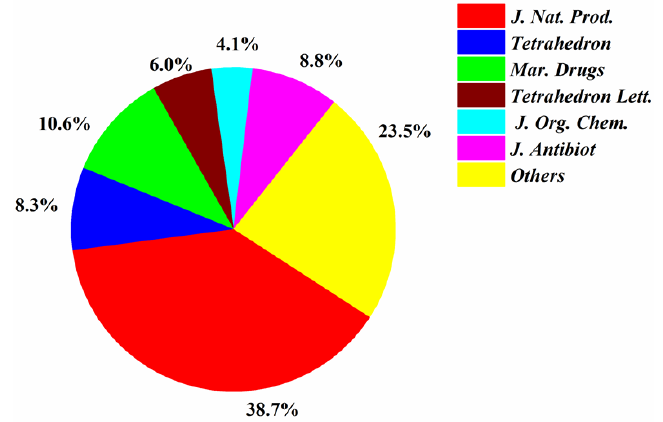
Figure 8. Percentages of new halogenated compounds published in different journals (1994–2019).